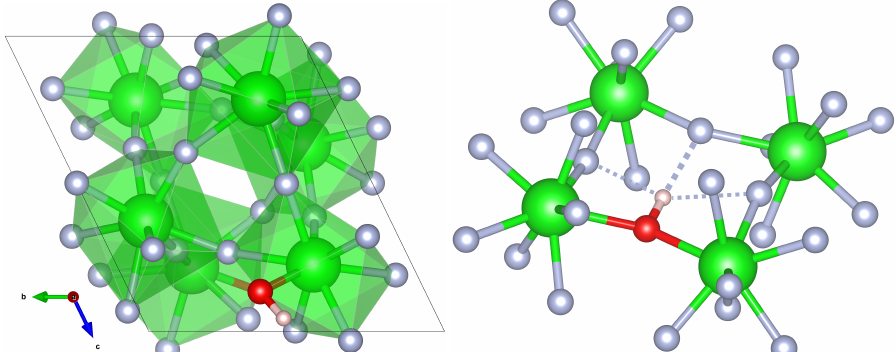
Figure 4. Relaxed unit cell of the most stable Zr 6 F 23 OH structure obtained by mono-hydroxylation at position 2 ( left ). The Hf 6 F 23 OH structure looks equivalent to the Zr species. The unit cell parameters are given in Table 3. The structural insert ( right ) shows the typical trifurcated H-bond with a main component (bold dashes) and two minor components (thin dashes). The structural H-bond data is listed in Table